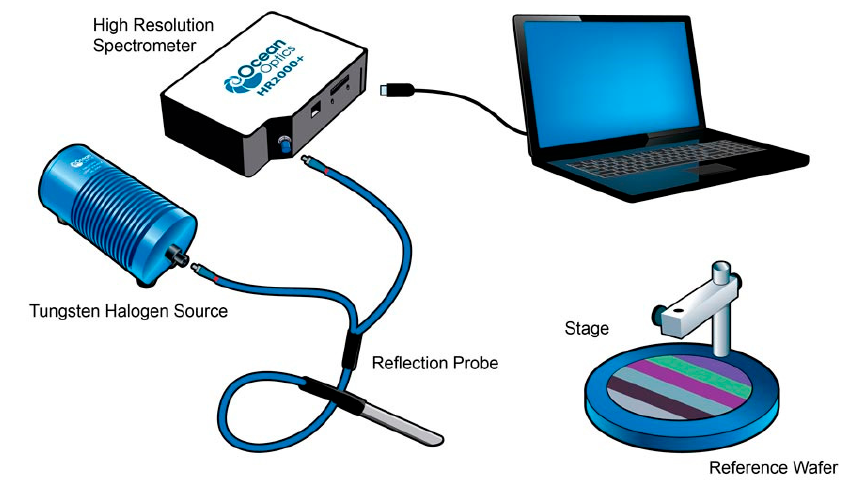
Figure 4. An optical device for measuring ultraviolet-visible radiation (UV-VIS) spectra.